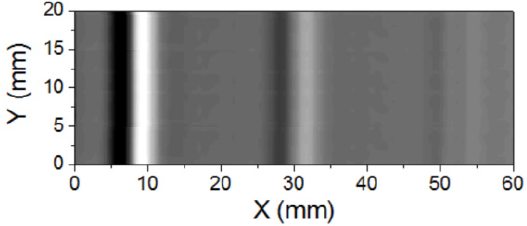
Figure 18. 2D graph of the scanning results.